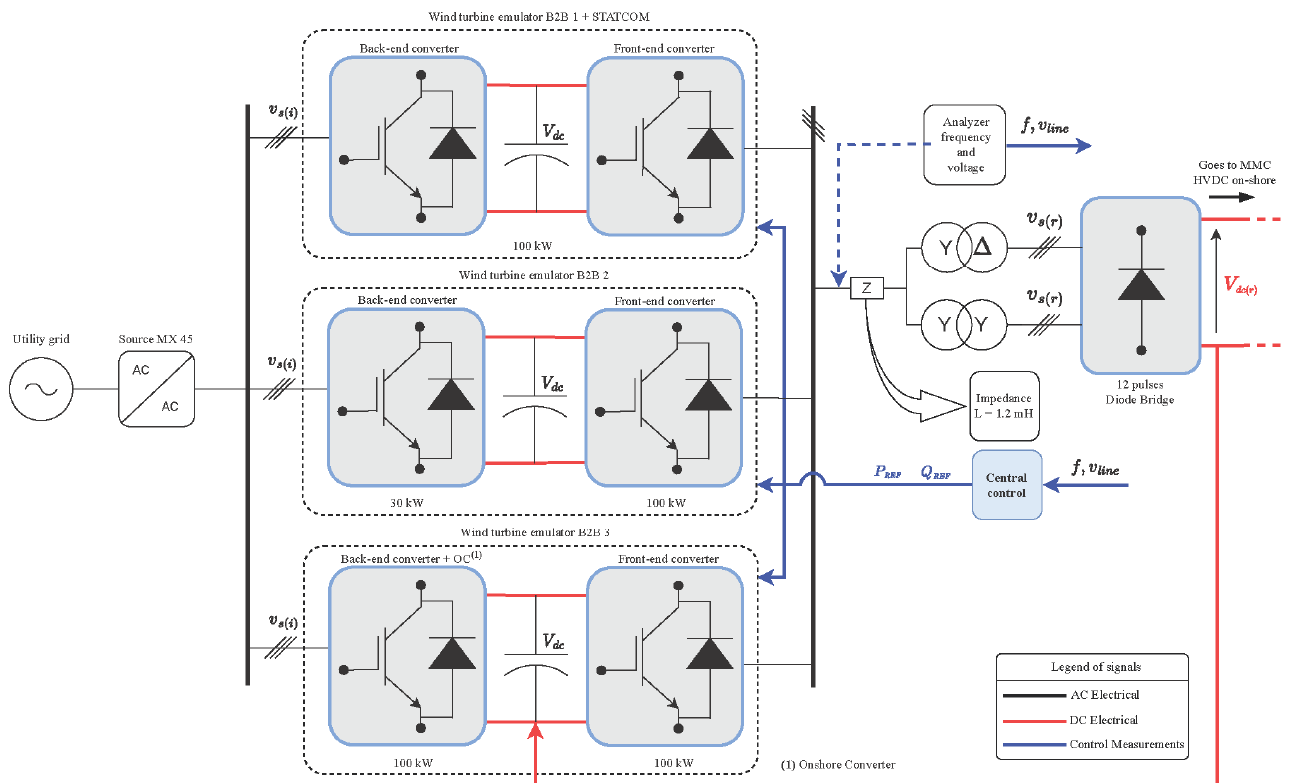
Figure 8. Test bench topology and offshore DC link in detail.